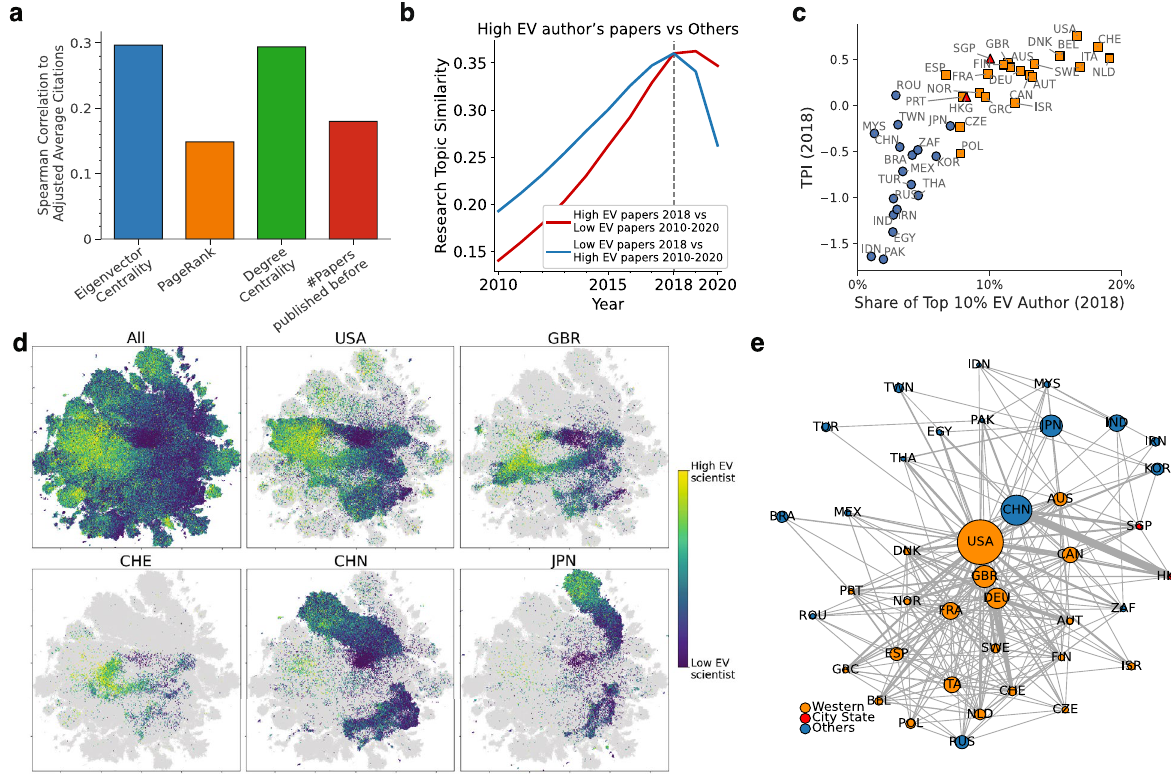
Figure 4. Information spreading on co-authorship network and research topic progress. ( a ) Blue, orange, green, and red bars show the Spearman correlation coefficients between the domain-adjusted citation count and eigenvector centrality, PageRank, degree centrality, and number of previously published papers for each author, respectively. ( b ) Comparison of T for the top 50% of papers (on the basis of the highest author eigenvector (EV)) and bottom 50% papers. The comparison is based on the year 2018. ( c ) The relationship between the TPI (2018) and the percentage of authors with the top 10% eigenvector centrality (2018) for each nation. ( d ) Visualization of the co-authorship network: Each scientist is colored in accordance with eigenvector centrality (yellow indicates high, and blue indicates low). The 2D position is obtained by UMAP 41 from the 128-dimensional LINE 28 embedding of the network. The authors of all nations (top left) and of five selected nations are plotted. ( e ) The network of nations based on international co-authorship density. Each edge is weighted by the number of co-authorship links between the pair of nations divided by the lower number of authors among the two nations. Node size indicates the number of authors in each nation. The figures were generated using matplotlib(3.6.0) and labeled with